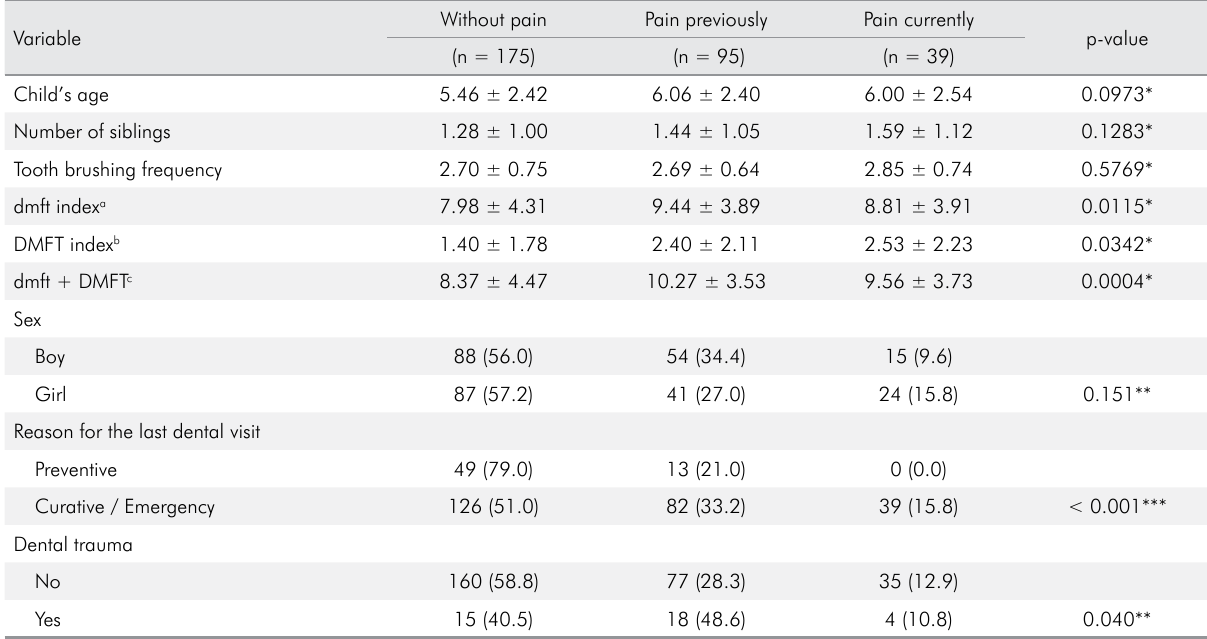
Table 2. Bivariate analysis of dental pain and the independent